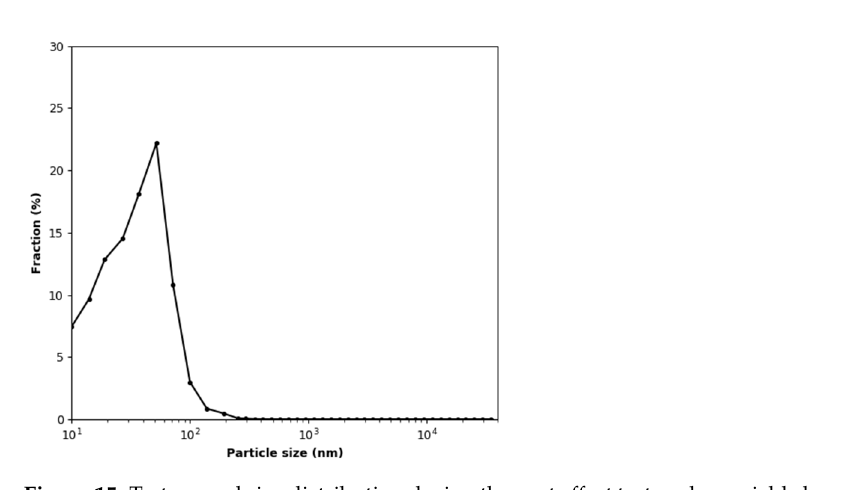
Figure 16. Readings from the aerosol detectors during the soot effect test under variable humidity conditions: ( a ) total particle number concentrations measured by the MiniWRAS; ( b ) output signal from the smoke detector.